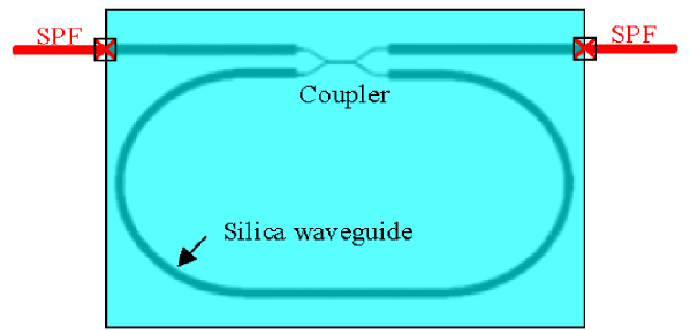
Figure 16. Schematic diagram of the WRR with a single-polarization fiber. Reprinted with permission